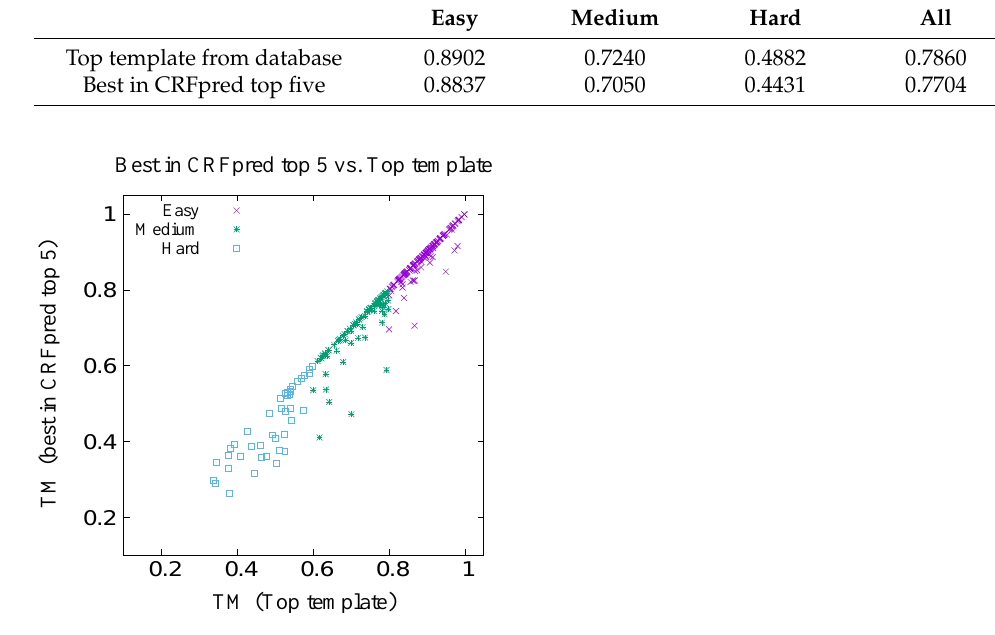
Figure 17. Comparison of the TM scores of 300 proteins with the best among top five predicted templates from CRFpred (through CRFalign) vs. the TM scores of the same proteins with the (true) top templates from the